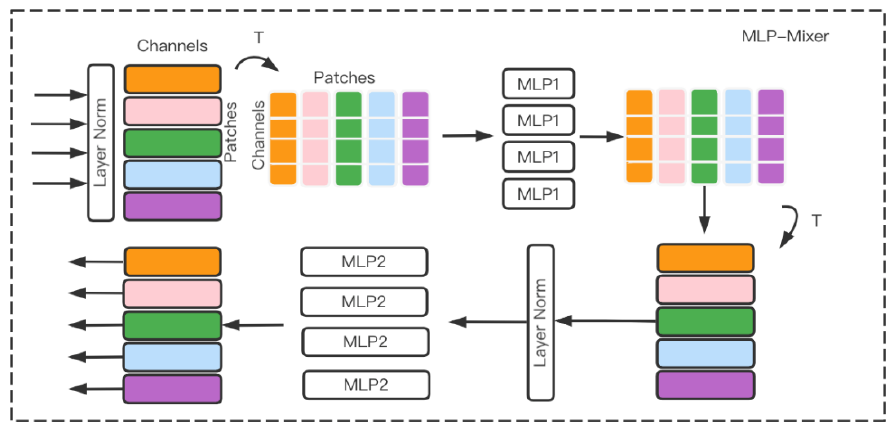
Figure 5. MLP-Mixer Model Diagram.